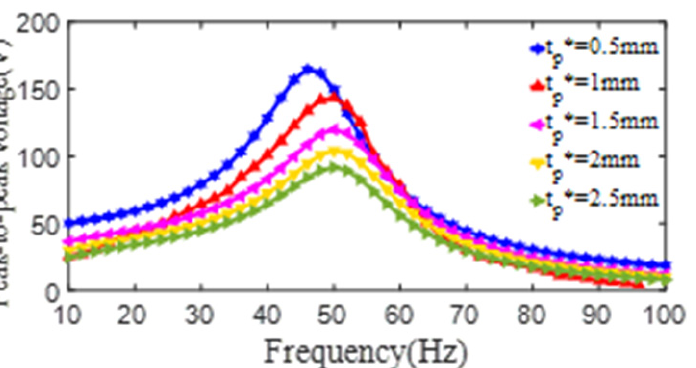
Figure 14. The relationship curves of the peak-to-peak voltage and the excitation frequency of PZT4 patch with different thickness ( d p* = 20 mm, D p* = 75 mm, t s* = 0.6 mm).